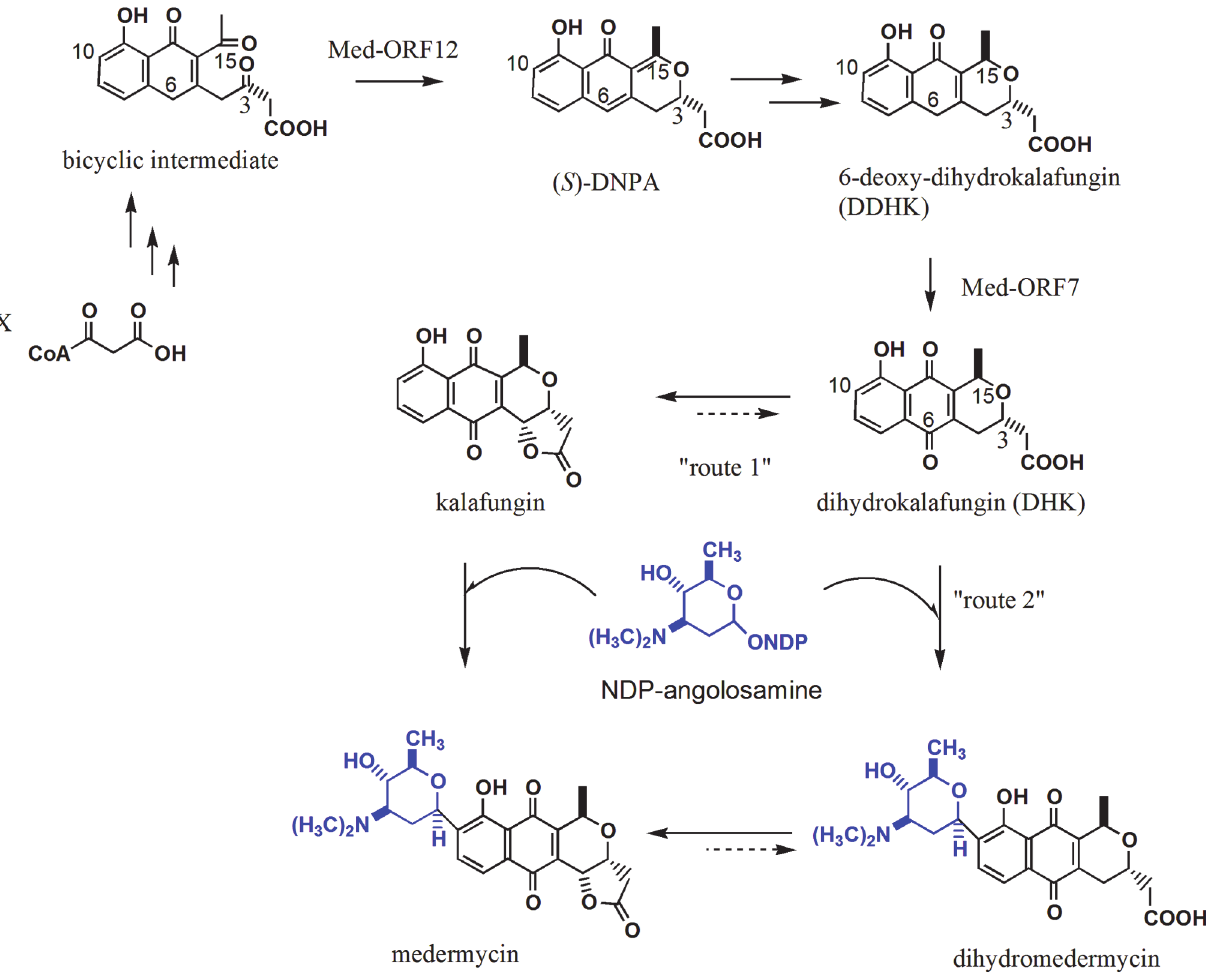
Fig 7. Proposed tailoring steps in the biosynthetic pathway of medermycin. ( S )-DNPA: 4-dihydro-9-hydroxy-1-methyl-10-oxo-3-H-naphtho[2,3-c]pyran- 3-acetic acid, as a first chiral intermediate in the pathway of medermycin. NDP-angolosamine: the specific glycosyl moiety formed under the control of seven glycosylating genes indicated in the med gene cluster in Fig. 1B. The conversion from DDHK to DHK could be catalyzed by an oxygenase encoded by med - ORF7 in the med gene cluster [26]. The numbering given is based on the biosynthetic origin of these